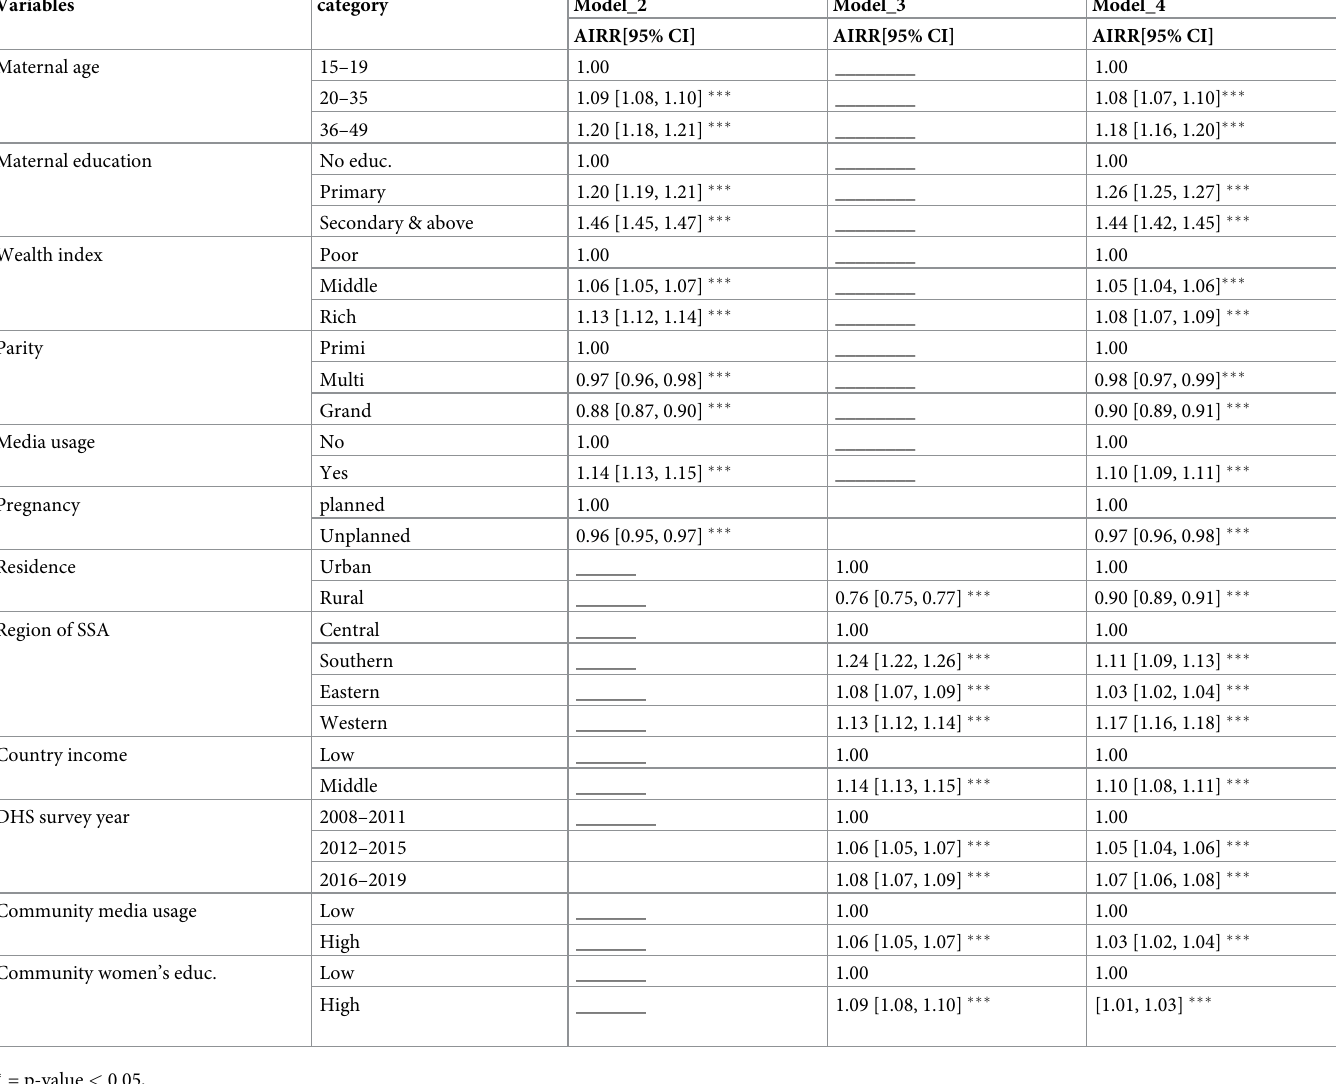
Table 3. Multilevel negative binomial regression analysis of individual and community level factors associated with the number of antenatal care visits in sub-Saha- ran Africa, DHS 2008–2019 (N = 256,425).